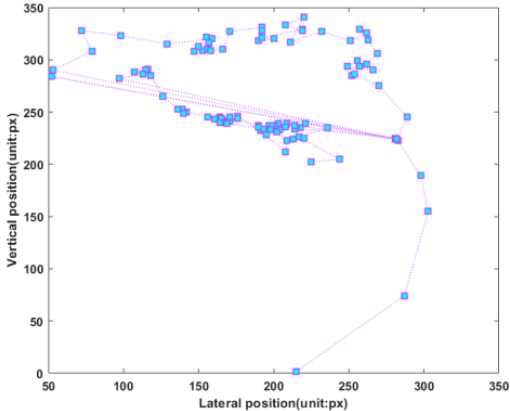
Figure 5. Trajectory of the center of mass during the melting of silicon dioxide.